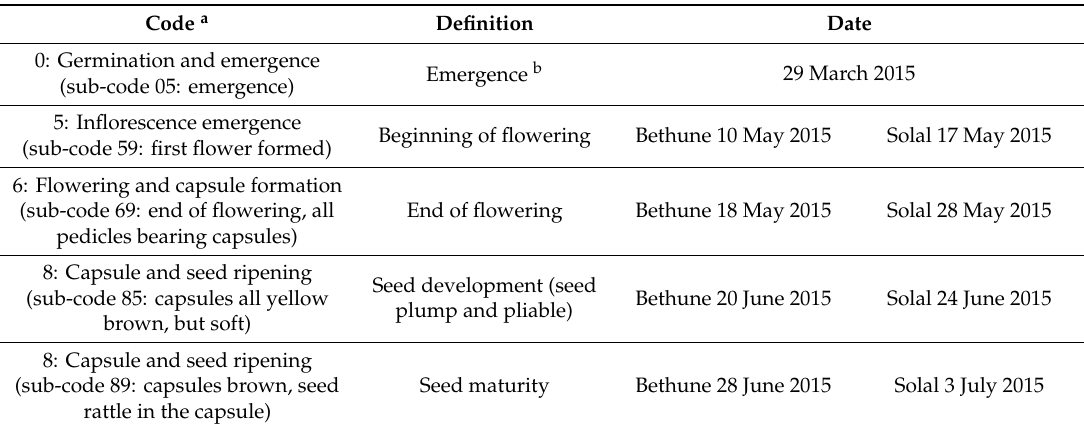
Table 5. Growth stage key for linseed Linum usitatissimum L in spring sowing (2015 growing season). Code a